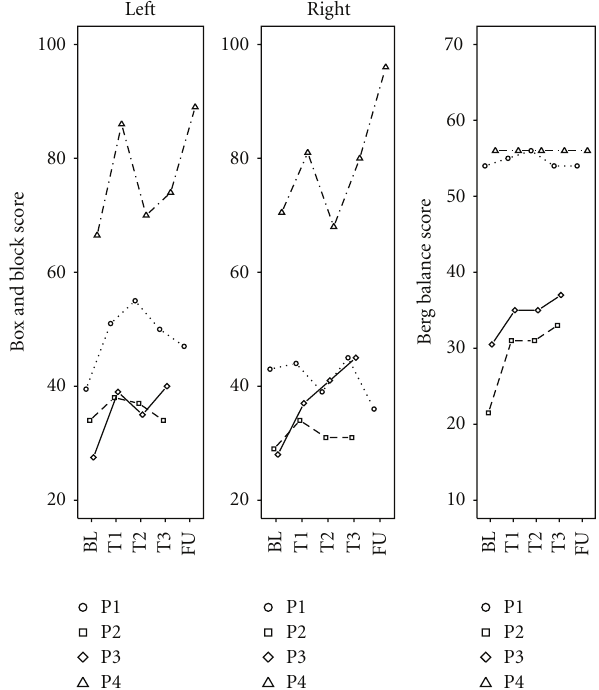
Figure 3: Manual dexterity and balance. Box and block scores and Berg balance scores for each patient. FU for patients 2 and 3 not displayed (see Section